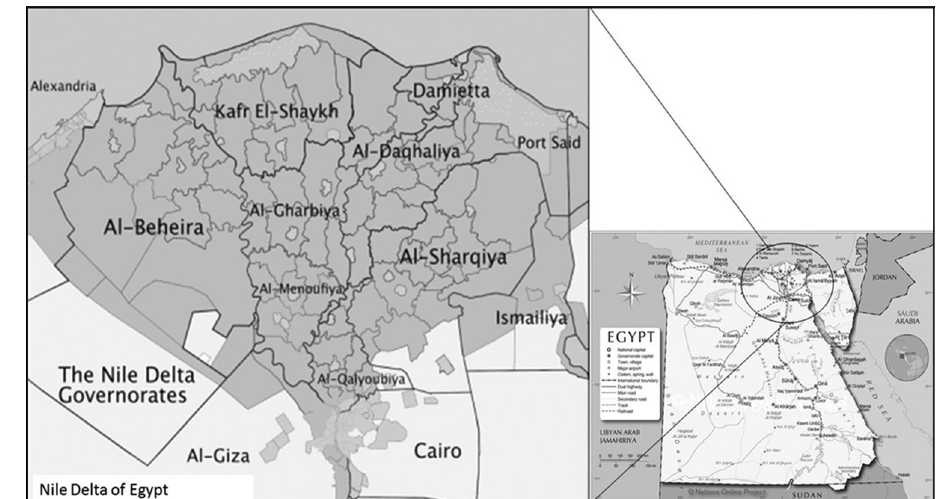
Figure-1: The map of Egypt (to the right) and the study area that includes three provinces: Kafr El-Shaykh, El-Beheira, and Alexandria (to the left) that contain a total of randomly selected 21 farms including 8 farms in Kafr El-Shaykh, 7 farms in El-Beheira, and 6 farms in